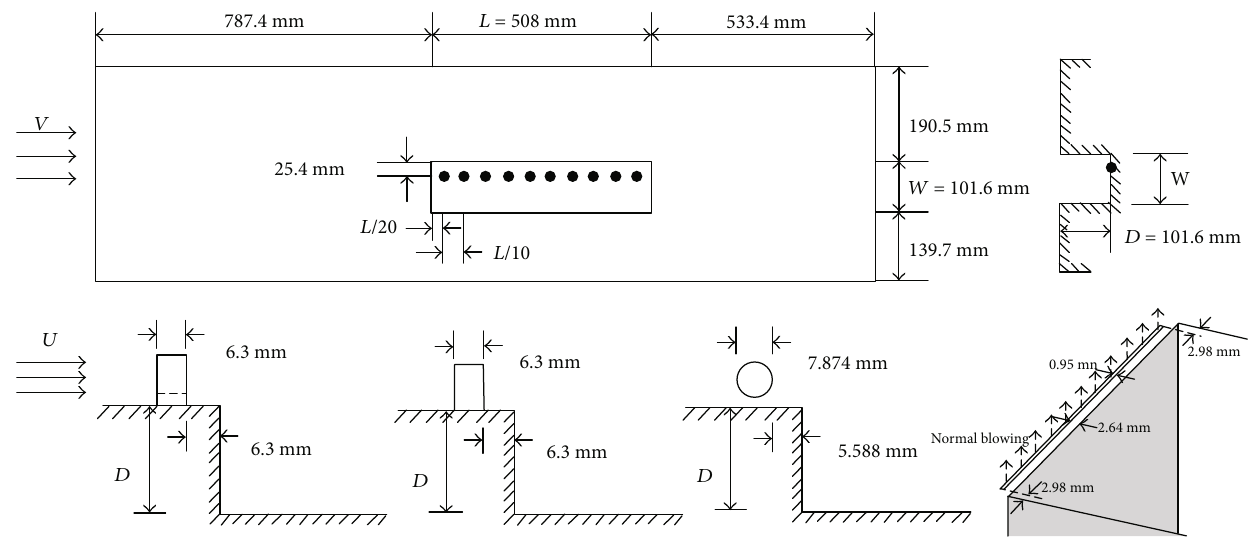
Figure 2: Geometries of